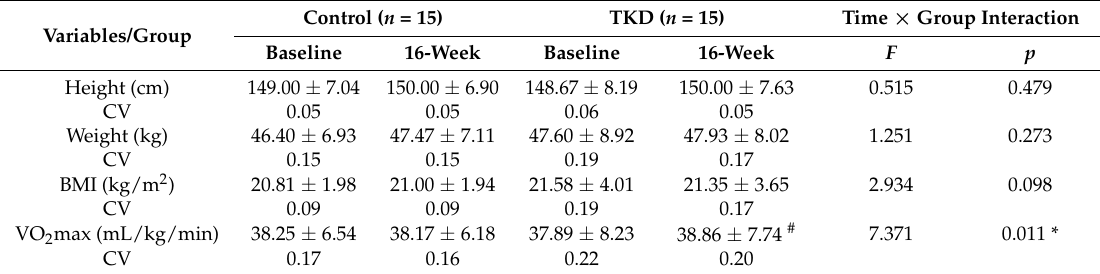
Table 3. Anthropometric characteristics in the control and TKD groups before and after the intervention.